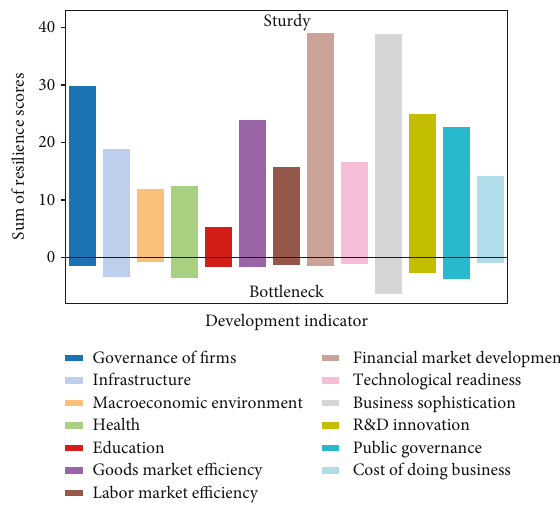
Figure 11: Bottlenecks and sturdy policy overall scores by development pillars. Bottlenecks: fragile policies in the 5 th percentile of relative priorities. Sturdy: resilient policies in the 95 th percentile of relative